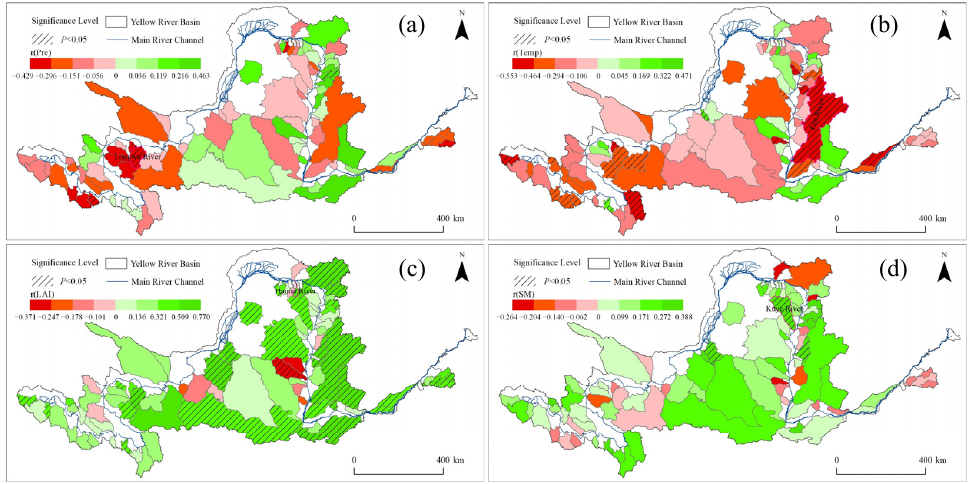
Figure 16. Correlation coefficients between the SWA and the Pre ( a ), Temp ( b ), LAI ( c ), and SM ( d ) for the permanent water bodies in each sub-basin.